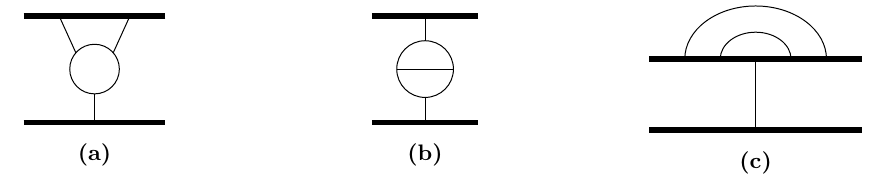
Figure 4. Sample diagrams that do not contribute in the classical limit. (a) and (b) are purely quantum from simple | q | counting arguments, whereas (c) is naively classical but scaleless in the soft